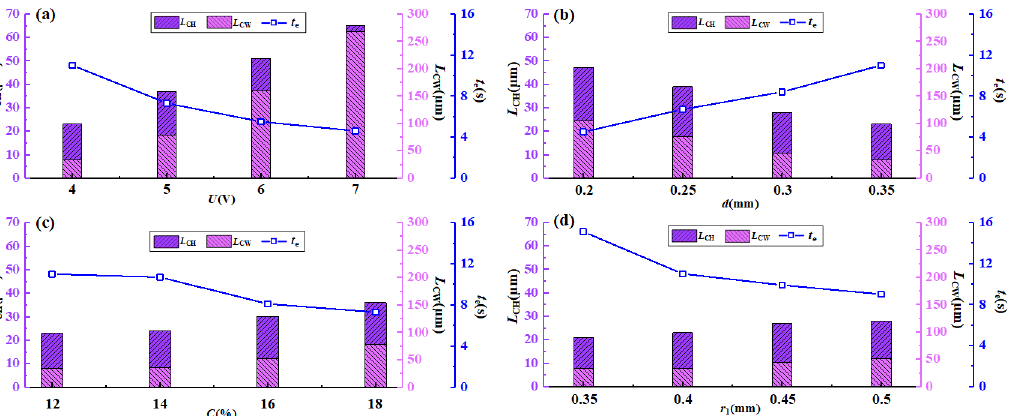
Figure 13. Comparison of MD-ECD machining effects: ( a ) Effect of machining voltage; ( b ) Effect of initial machining gap; ( c ) Effect of electrolyte concentration; ( d ) Effect of electrode radius.